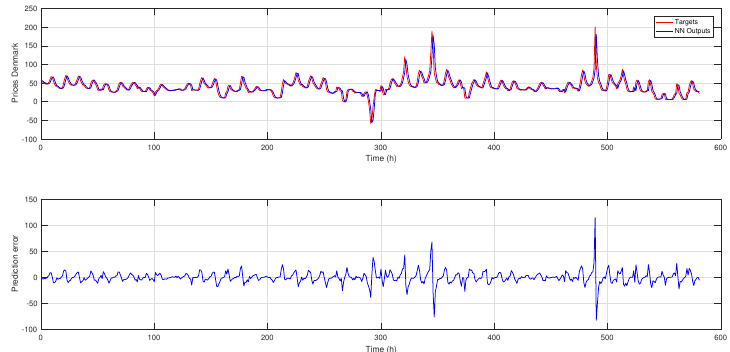
Figure 6. Energy price forecasting for Denmark time series data.